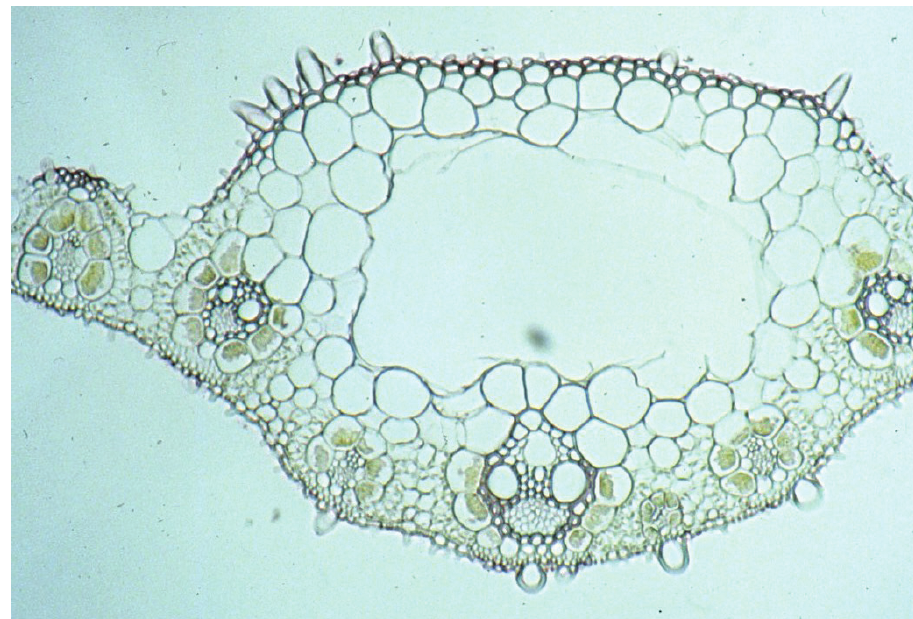
Figure 8. Cross section of leaf of Diplache fusca subsp. uninervia (Snow 5916-F) displaying nearly identical midrib anatomy as that of subspecies muelleri (see Fig.